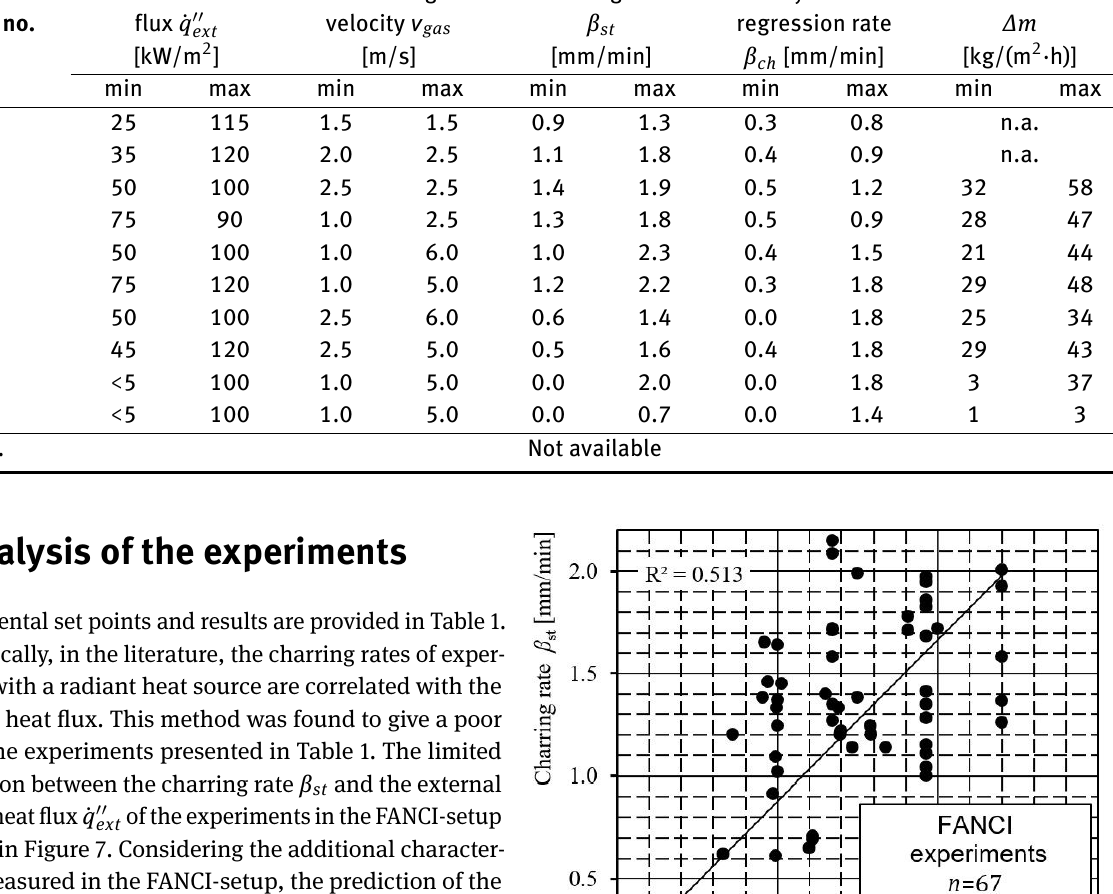
Table 1: Set points and measurements of the experiments performed with the FANCI-setup. Experimental External heat Reference gas Charring rate Char layer surface Mass loss rate velocity v gas β st regression rate series no. flux ˙ q ′′ ext